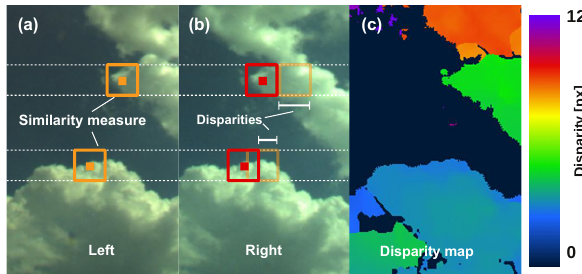
Figure 9. Illustration of dense stereo matching using epipolar- rectified images. The correspondence information is stored in a dis- parity map. Each disparity D( x ) > 0 then defines a correspondence between two image points x L,V and x R,V and can be used for trian- gulation, which results in a dense 3-D point